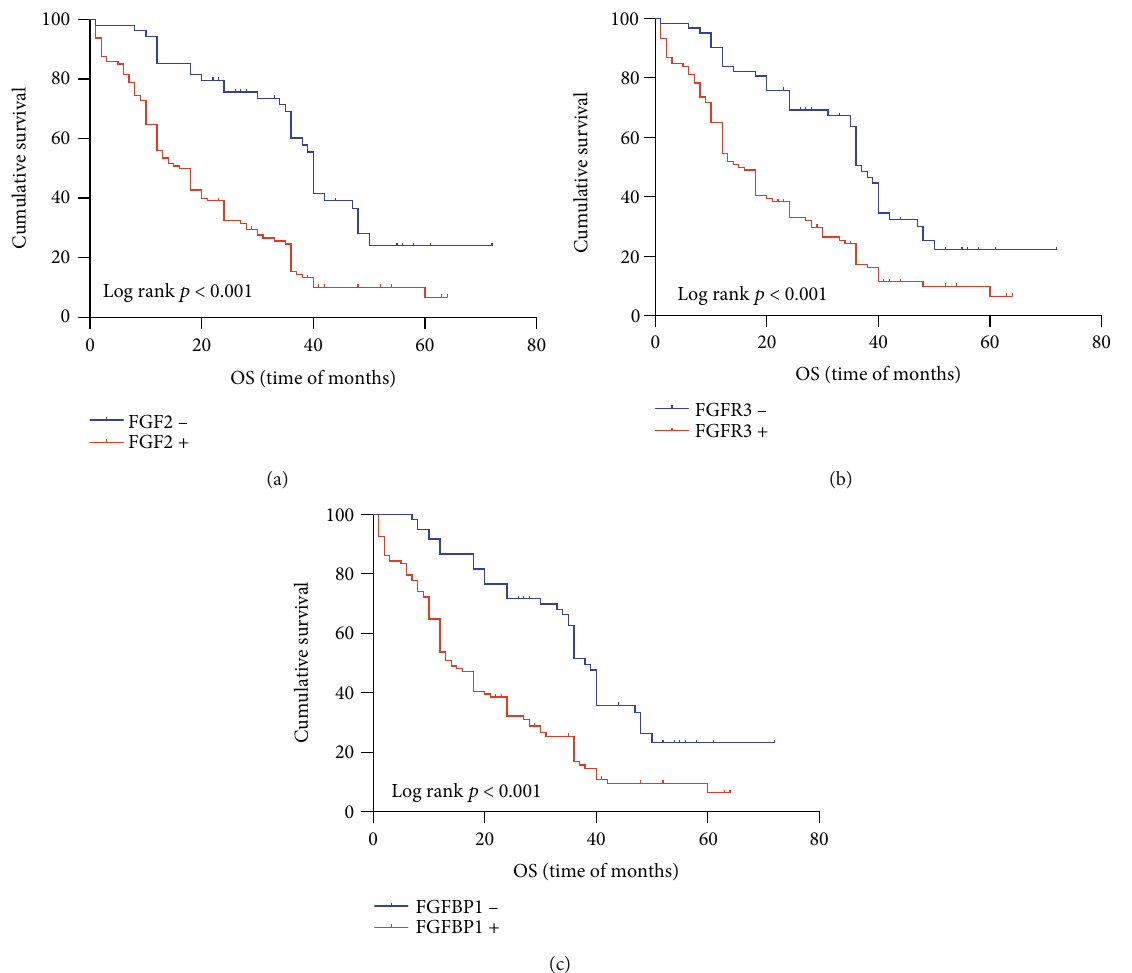
Figure 4: Kaplan – Meier curves for overall survival of ESCC with FGF2, FGFR3, and FGFBP1 expression. (a) Patients expressing high level of FGF2 have a signi fi cantly shorter survival ( p < 0 : 001 ); (b) patients expressing high level of FGFR3 have a signi fi cantly shorter survival ( p < 0 : 001 ); (c) patients expressing high level of FGFBP1 have a signi fi cantly shorter survival ( p < 0 : 001